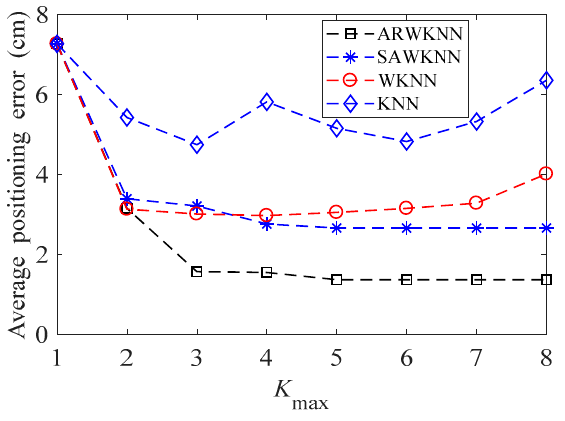
Figure 10. In 2-D, the impact of K max on the average positioning error.